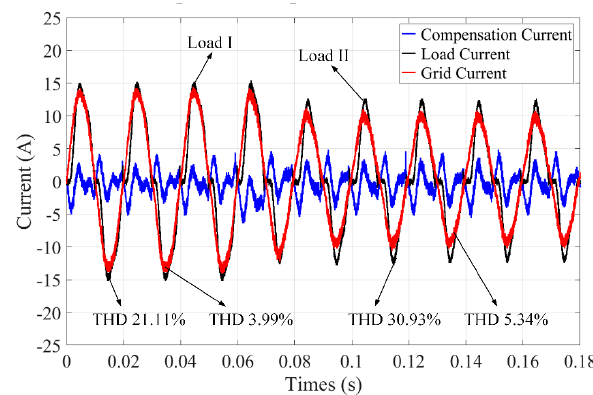
Figure 13. Experimental results of the current waveforms for PWM APF under the load change conditions.